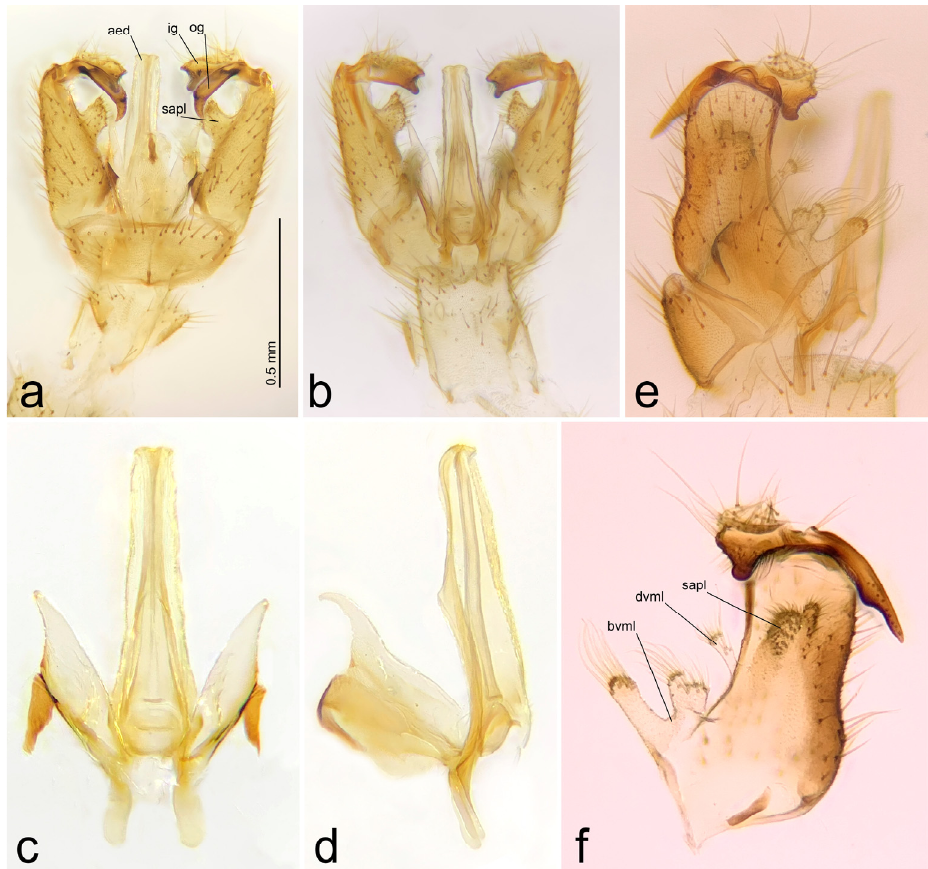
Figure 4. Atypophthalmus (Atypophthalmus) vanewrighti sp. nov., holotype male; ( a ) Hypopygium in dorsal view; ( b ) idem in ventral view; ( c ) Aedeagal guide and parameres in dorsal view; ( d ) idem in lateral view; ( e ) Right gonocoxite in lateral view from outside; ( f ) idem from inside.